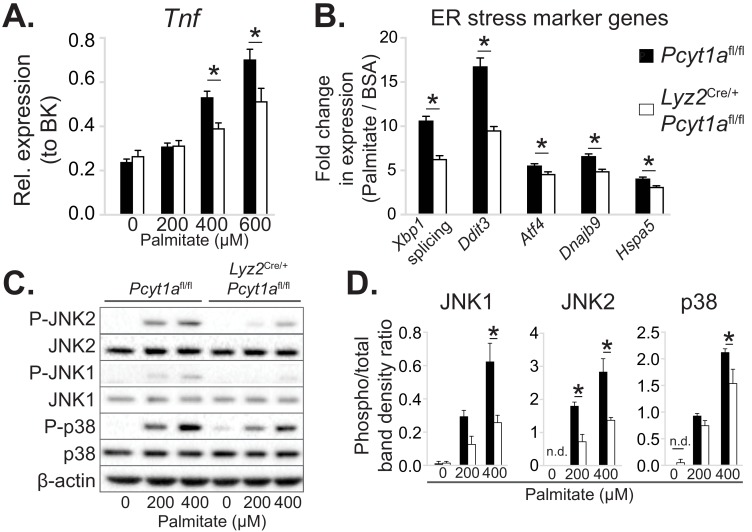
Pcyt1a deficiency protects macrophages from palmitate-induced ER stress and inflammation.(A) Tnf expression levels in Pcyt1afl/fl (n=5) or Pcyt1afl/fl
Lyz2Cre/+ (n=3) BMDMs treated with indicated doses of palmitate for 16 hours. (B) Fold induction (compared to BSA alone) of indicated ER stress marker gene expression Pcyt1afl/fl (n=7) or Pcyt1afl/fl
Lyz2Cre/+ (n=8) BMDMs treated with 250 μM palmitate for 16 hours. (C) Representative Western blots and (D) their densitometry quantification of Pcyt1afl/fl (n=5) or Pcyt1afl/fl
Lyz2Cre/+ (n=3) BMDMs treated with indicated doses of palmitate for 16 hours. ∗p < 0.05 between genotypes, error bars indicate SEM. All presented experiments are representative of at least 3 BMDM cultures.